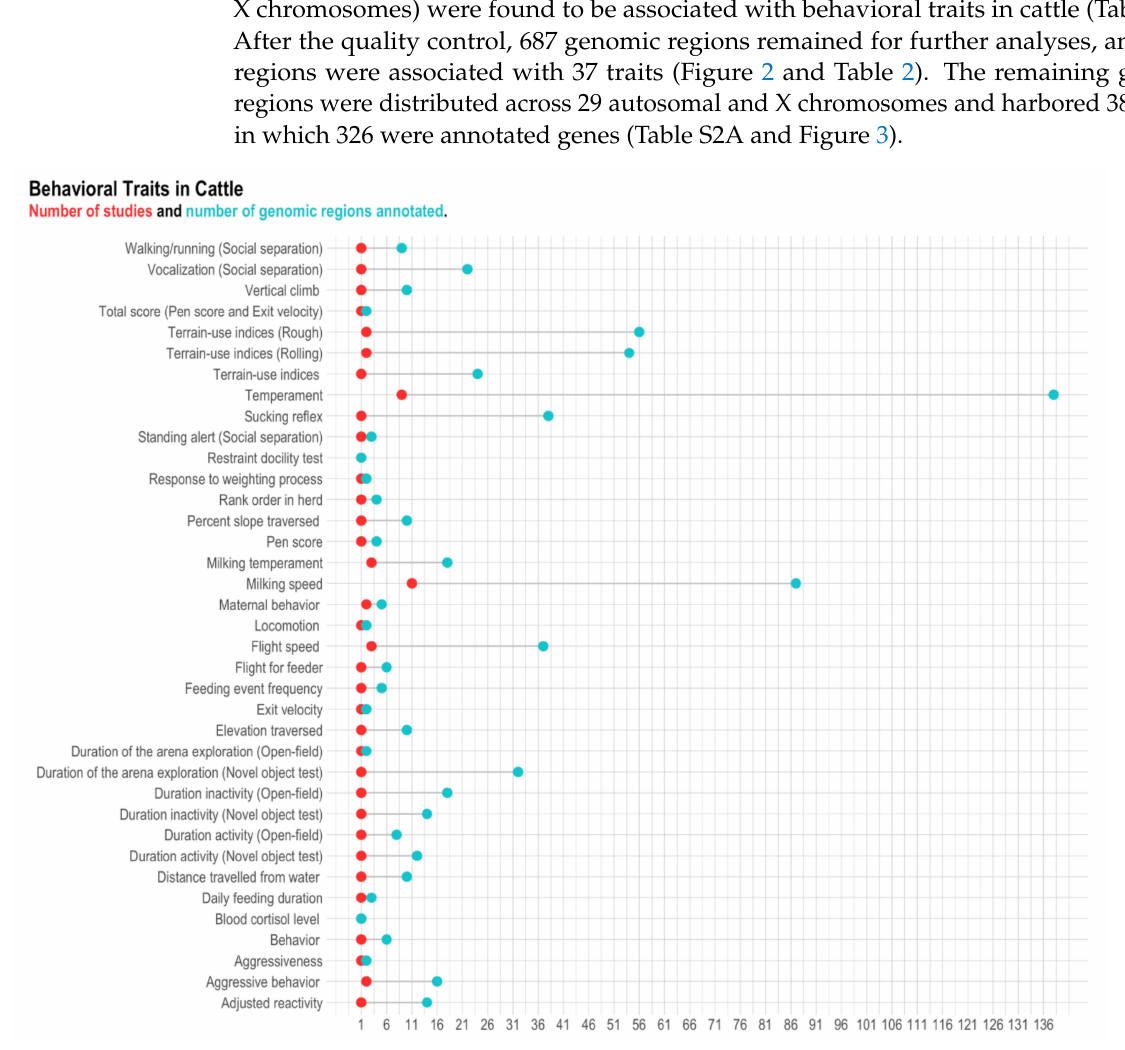
Figure 2. Number of genomic regions retrieved and references for each behavior-related trait in cattle. Red dots represent the number of references, and blue dots represent the number of genomic regions. Traits with a single-colored dot (e.g., restraint docility test) mean that the number of studies is equal to the number of genomic regions (therefore, the dots